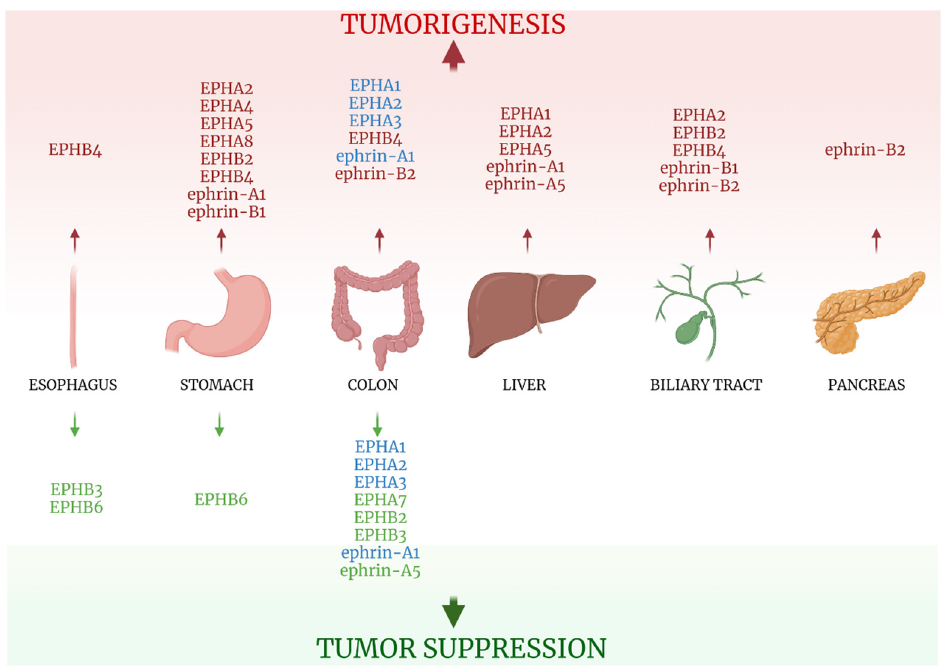
Figure 4. EPH/ephrin family role in solid tumors of organs of the gastrointestinal tract, liver, biliary tract, and pancreas. Red-colored EPHs/ephrins enhance tumorigenesis, while green-colored ones suppress it. It is unclear if EPHA1, EPHA2, EPHA3, and ephrin-A5 enhance tumorigenesis or tumor suppression (blue font). See text and Table 3. Created with BioRender.com (accessed on 2 August